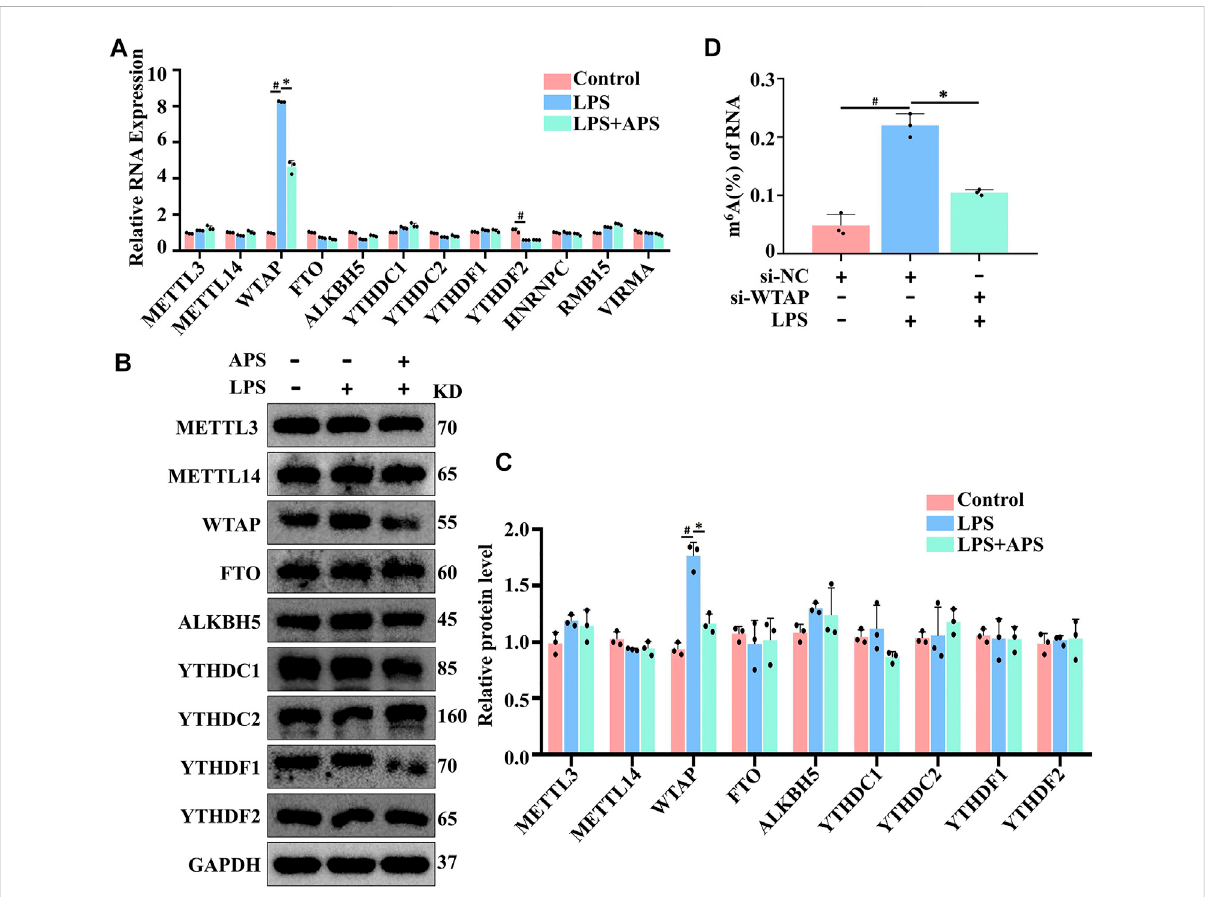
FIGURE 3 APS decreased LPS-induced WTAP gene in THP-1 macrophages. THP-1 macrophages were treated with APS (500 μ g/ml) for 24 h and then inducedwithLPS(10 μ g/ml)for4 h.m 6 Amodi fi cationsystem-relatedproteinsweredetectedby (A) qRT-PCRand (B) westernblot. (C) Densitometry quanti fi cation of protein. (D) THP-1 macrophages were transfected with si-WTAP and then induced with LPS (10 μ g/ml) for 4 h. Overall m 6 A level in RNA is detected by m 6 A RNA methylation quanti fi cation. # p < 0.05 compared with Control group. * p < 0.05 compared with LPS group. Data represent the mean ± SEM. n = 3 per